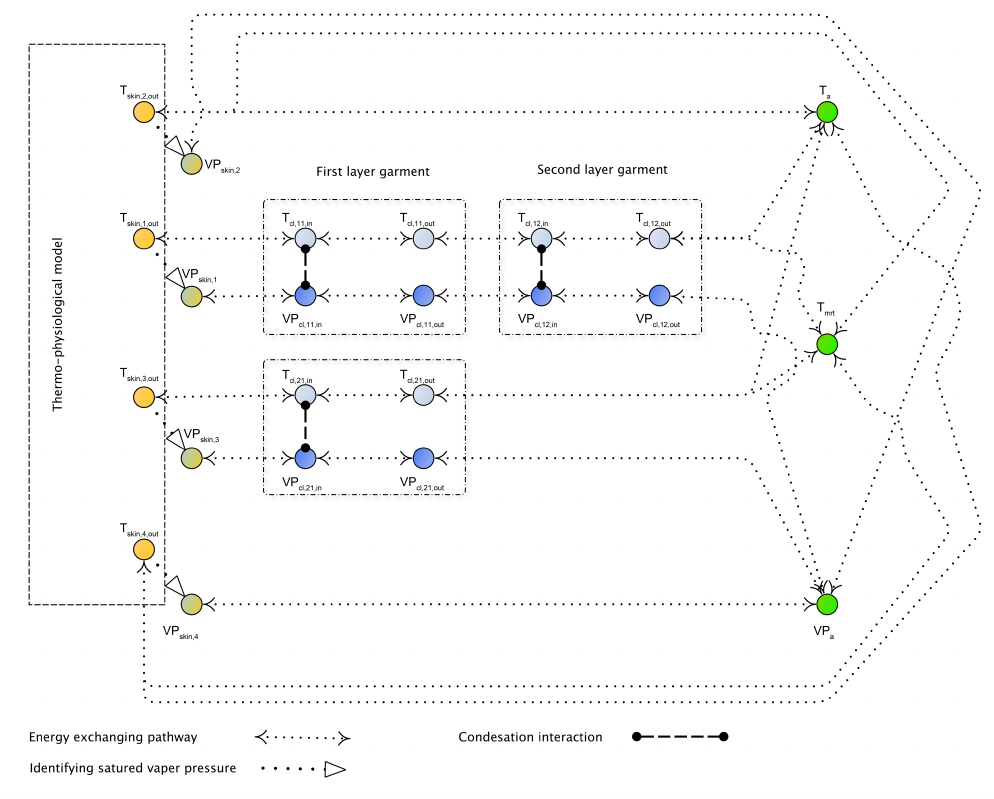
Figure 4. The flow chart of all energy fluxes of the double-layer clothing